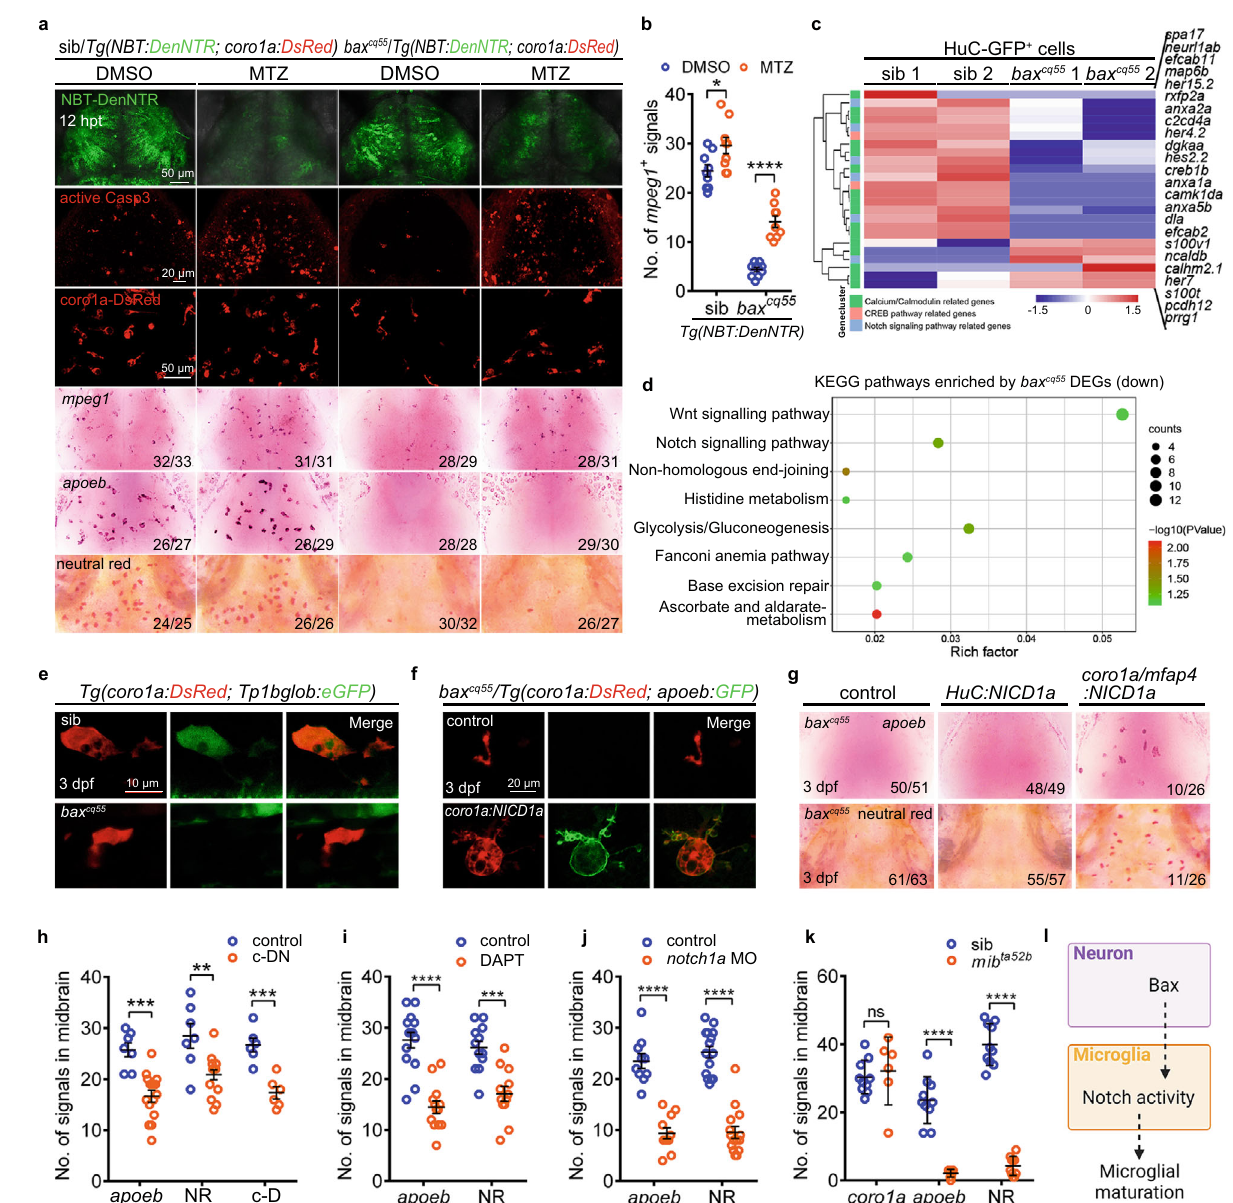
Fig. 3 | Baxcontrolsmicroglial maturationvia Notch signaling. a The images of NBT-DenNTR + , active Casp3 + , coro1a-DsRed + , mpeg1 WISH, apoeb WISH and NR staining signals in DMSO and/or MTZ-treated midbrains at 12h post-treatment (hpt). b Quanti fi cationof mpeg1 + signalsin( a )(DMSO:sib: n =9, bax cq55 : n